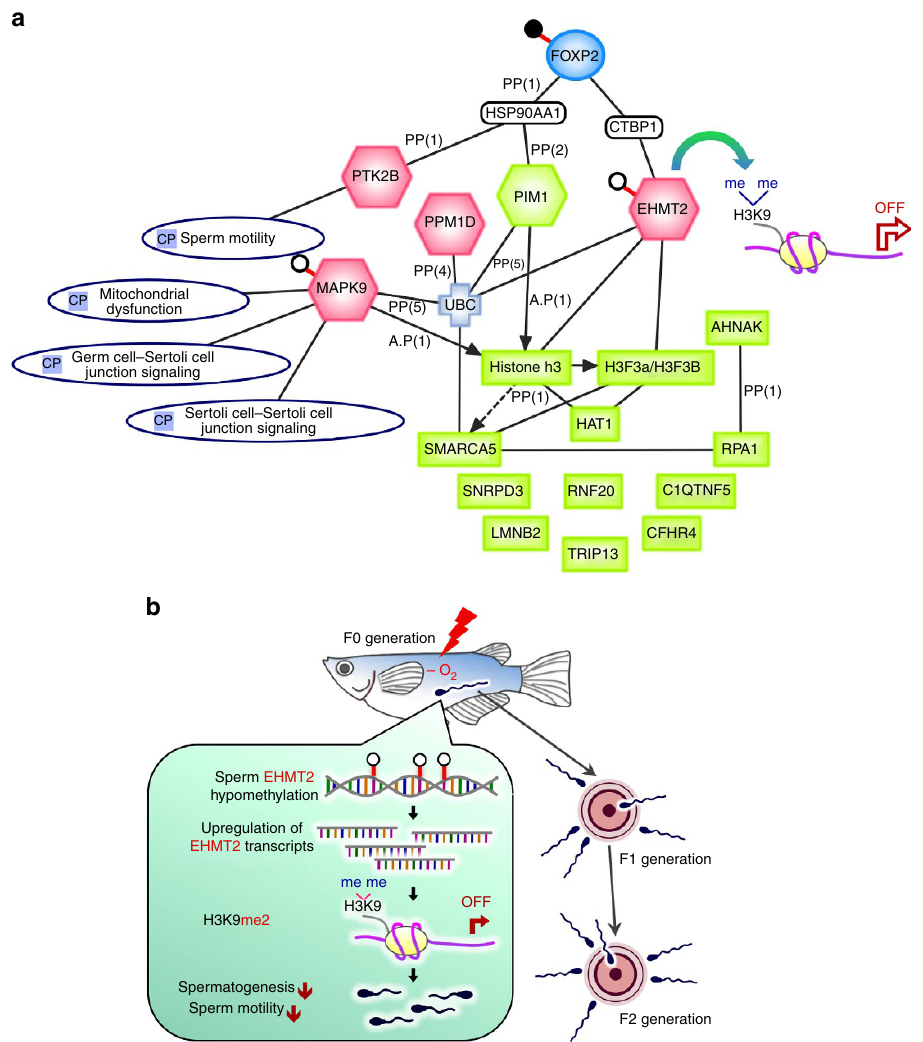
Figure 5 | Integrated omics analysis. ( a ) IPA integrates the transgenerational effects at the epigenomic, transcriptomic and proteomic levels, which are represented by oval, hexagonal and rectangular symbols, respectively. Black and white dots indicate hypermethylation and hypomethylation, respectively. Pink and green denote changes in the expression of genes or proteins, respectively. CP, canonical pathways. ( b ) Schematic diagram of the current